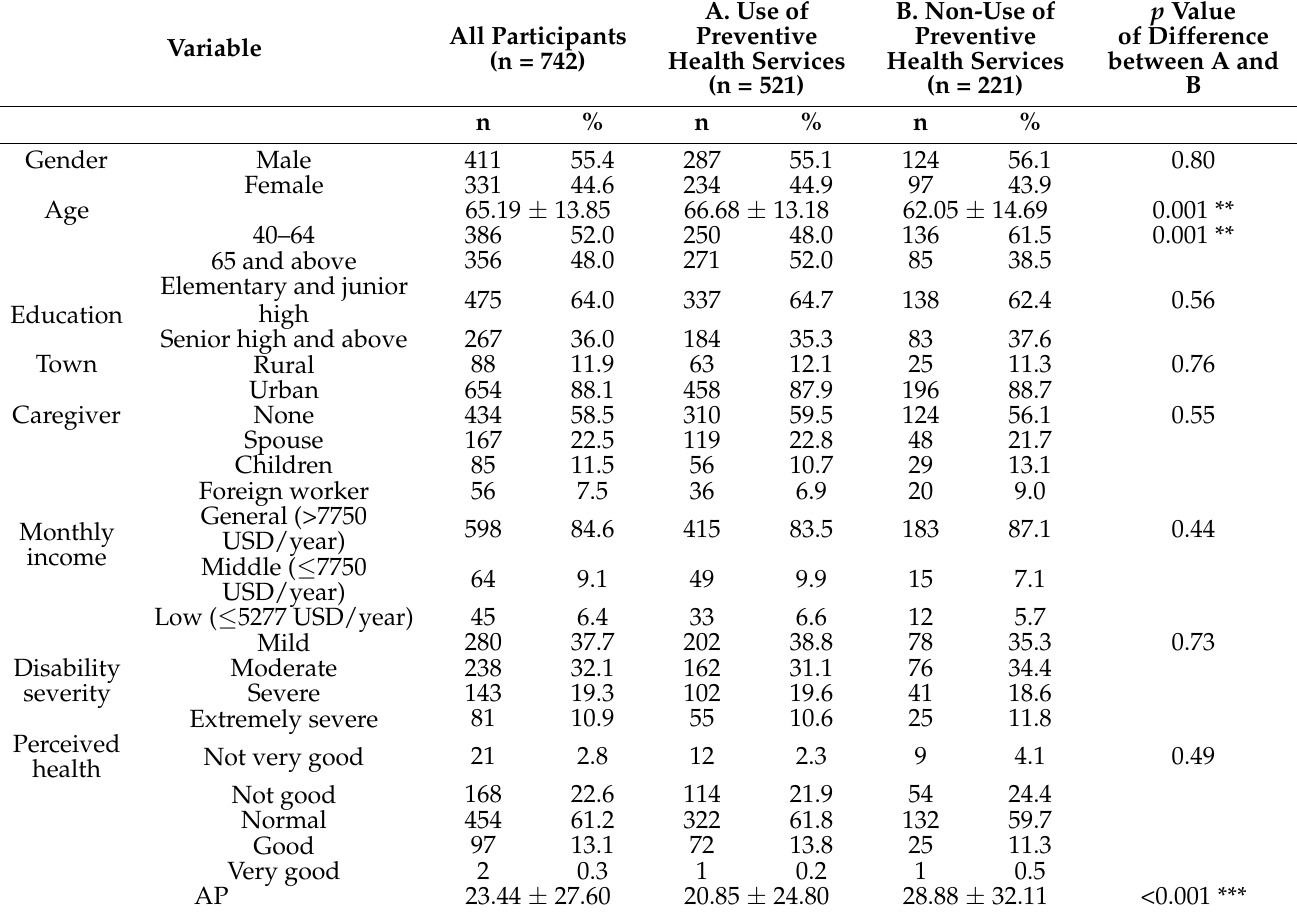
Table 1. Social demographic characteristics of people with disabilities in terms of use and non-use of preventive health services.